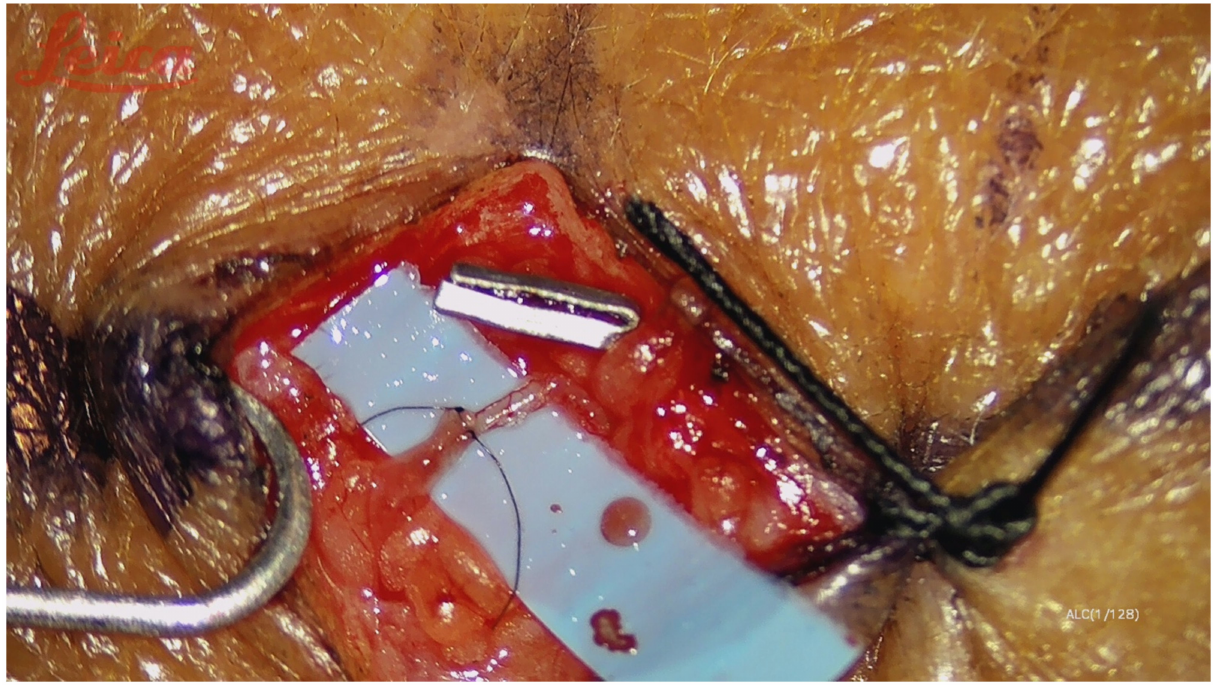
Figure 1. End to end lymphaticovenous